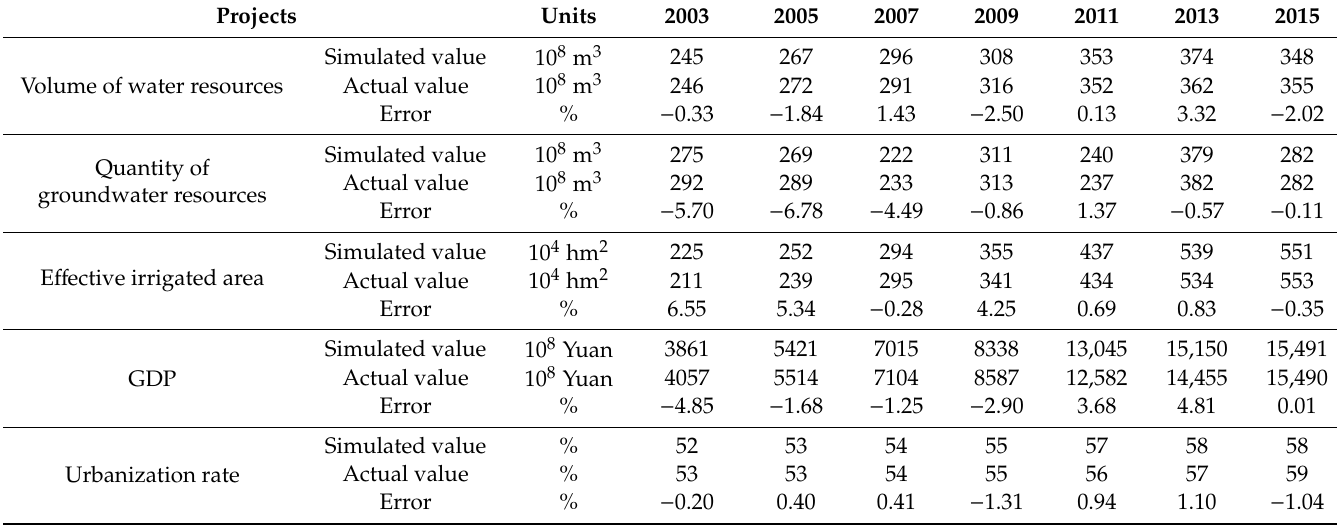
Table 2. Historical test results of